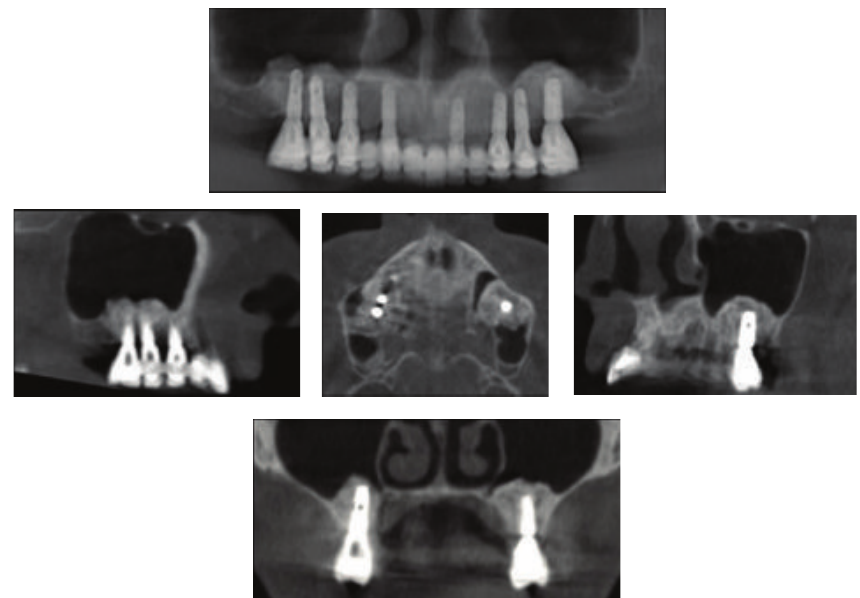
Figure 3: 60-month follow-up of the augmented sinus. (2) Bone height at T1. (3) Bone height at follow-up